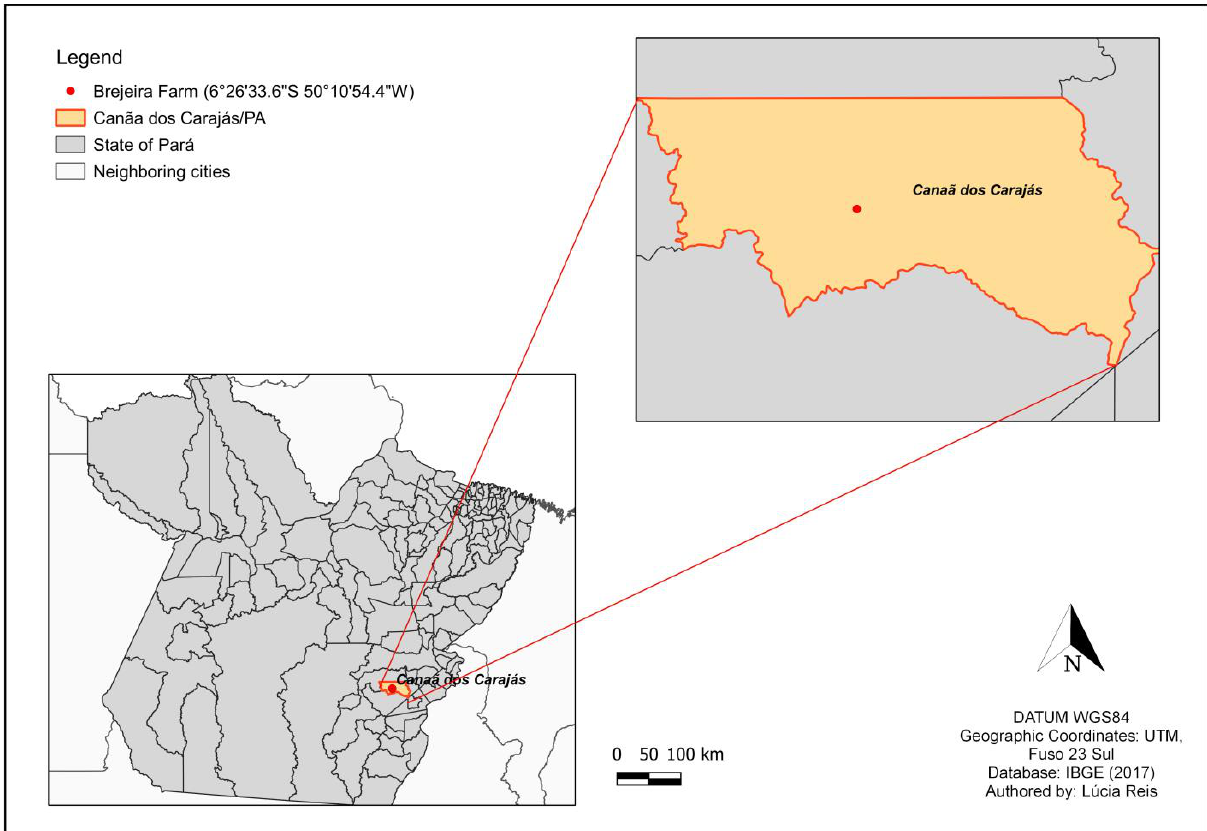
Figure 1. Location of the municipality of Canaã dos Carajás (outlined in orange) and the arthropod collection site (red dot). collection site (red